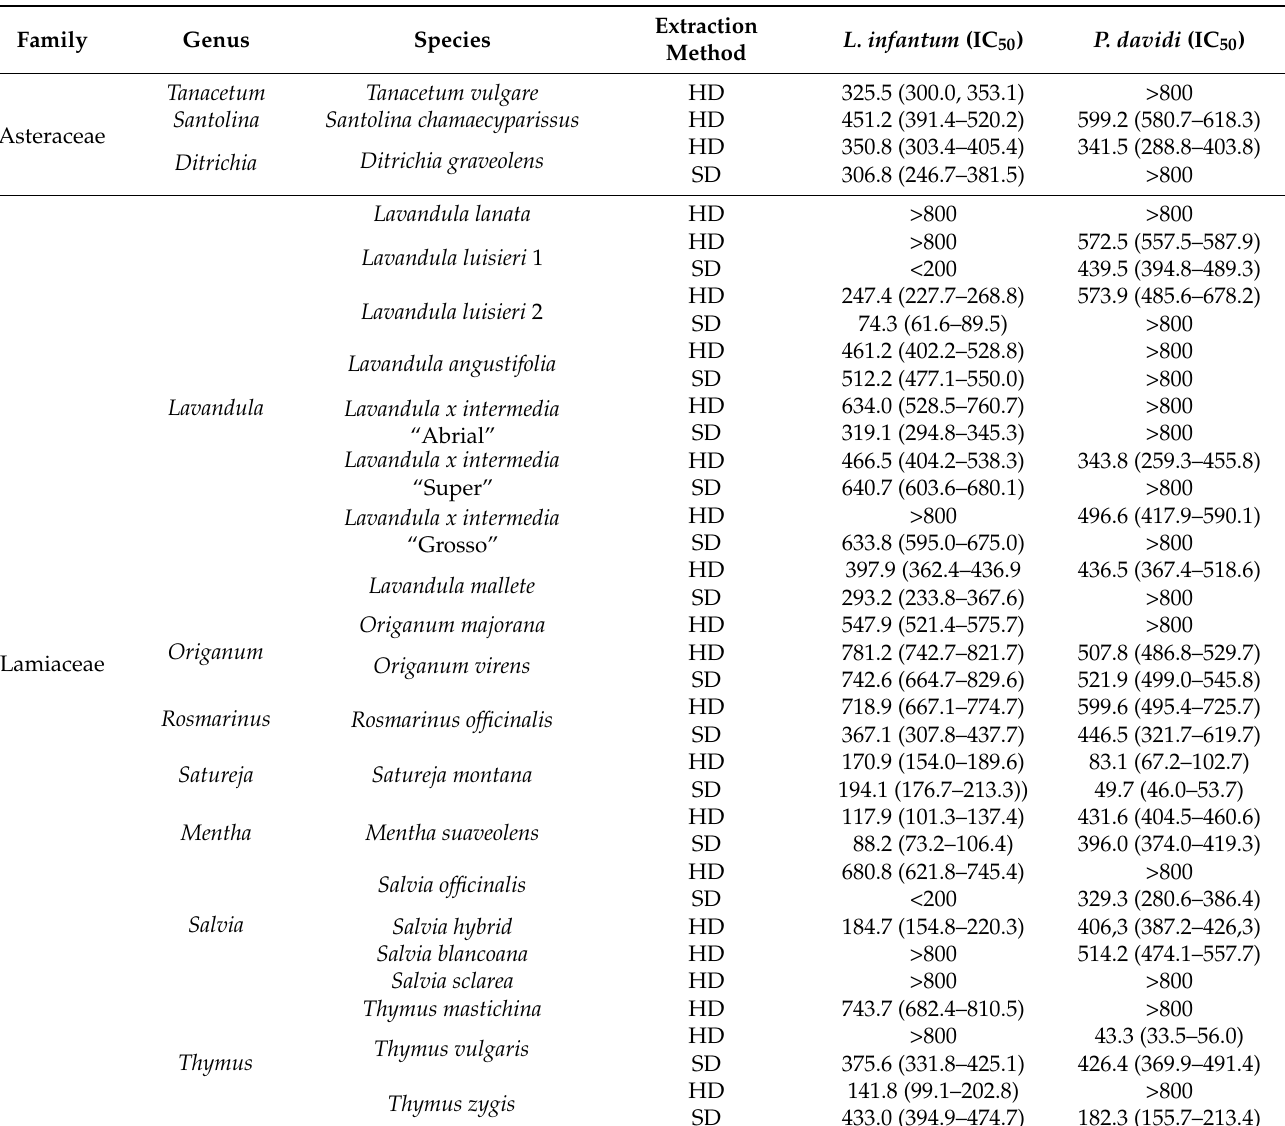
Table 1. Effects of the tested EOs from Lamiaceae and Asteraceae species on L. infantum and P. davidi (IC 50 ) a